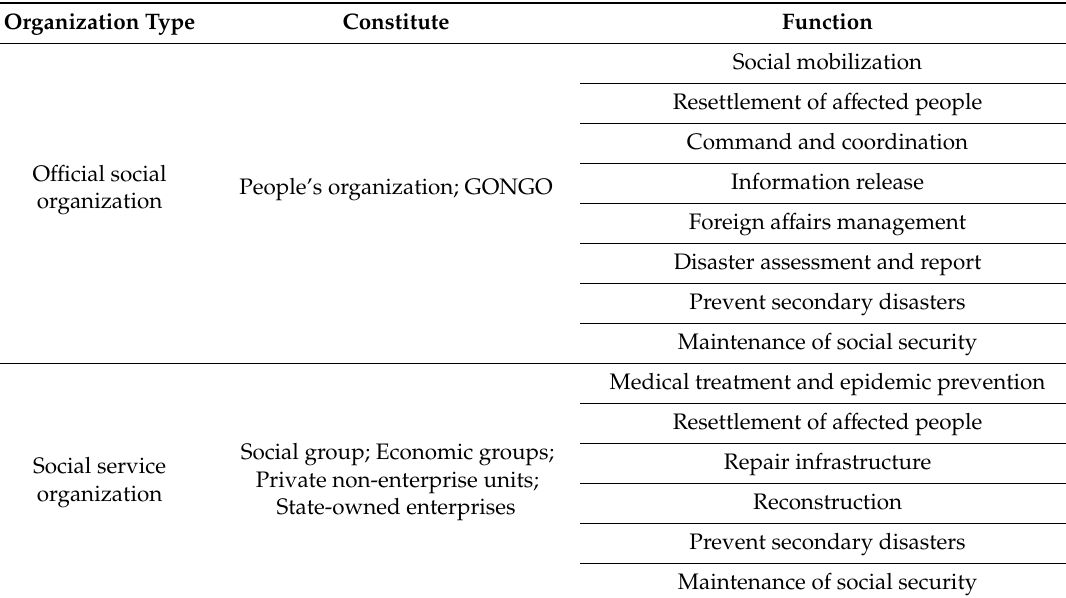
Table 6. The classification and functions of social